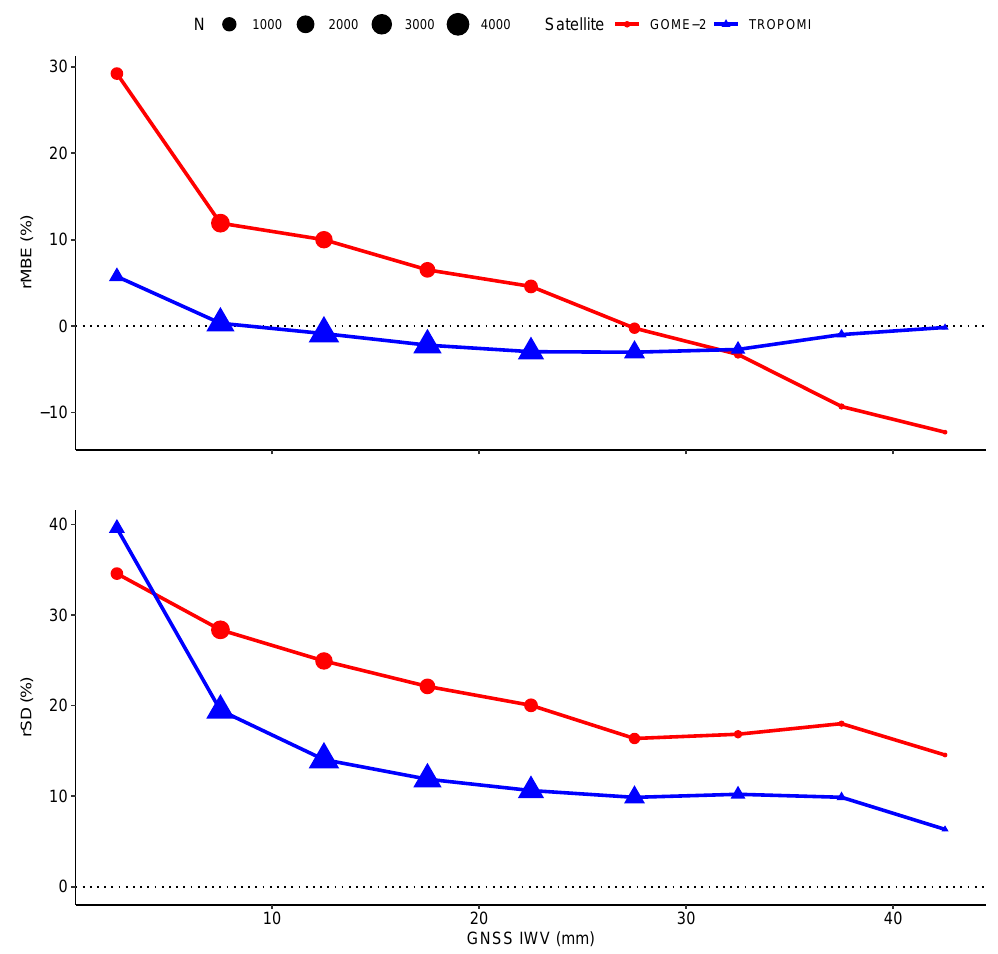
Figure 4. rMBE and rSD against IWV in bins of 5 mm. Size of points indicates the number of data in that